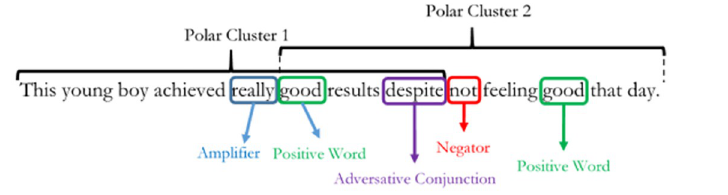
Fig 1. Sentence structure. The diagram shows a typical polarized sentence structure.